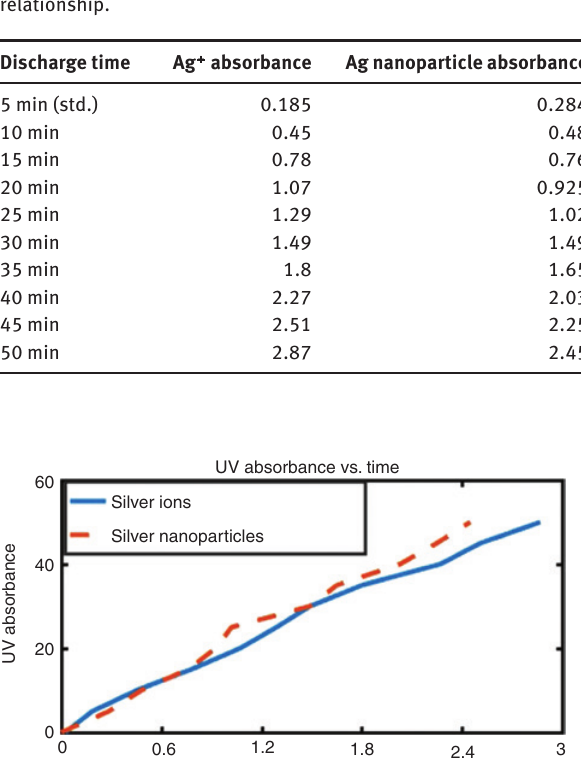
Table 5: The Ag + and Ag nanoparticle UV-Vis spectroscopy relationship.